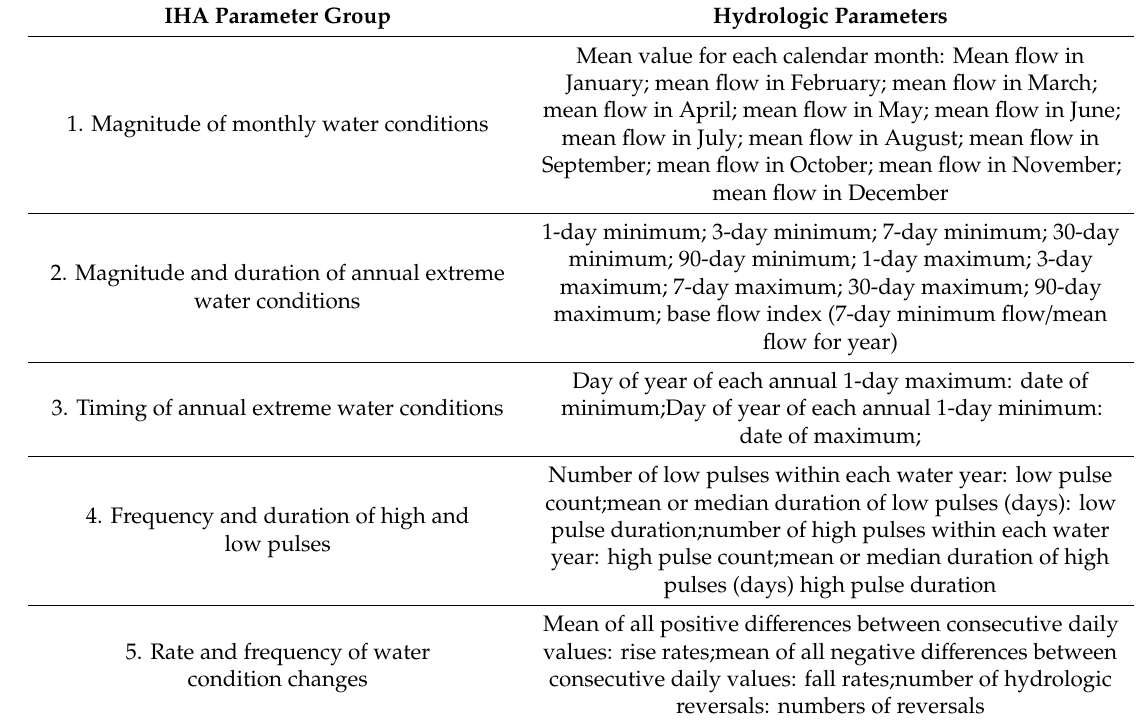
Table 2. Summary of the 32 IHAs.